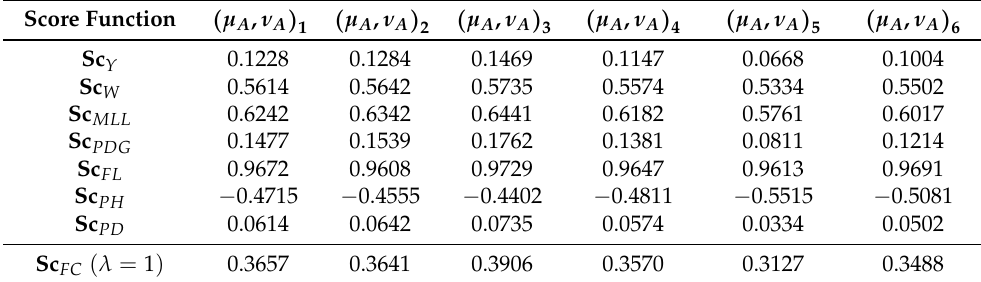
Table 6. Score values of alternatives average p-rung orthopair fuzzy sets